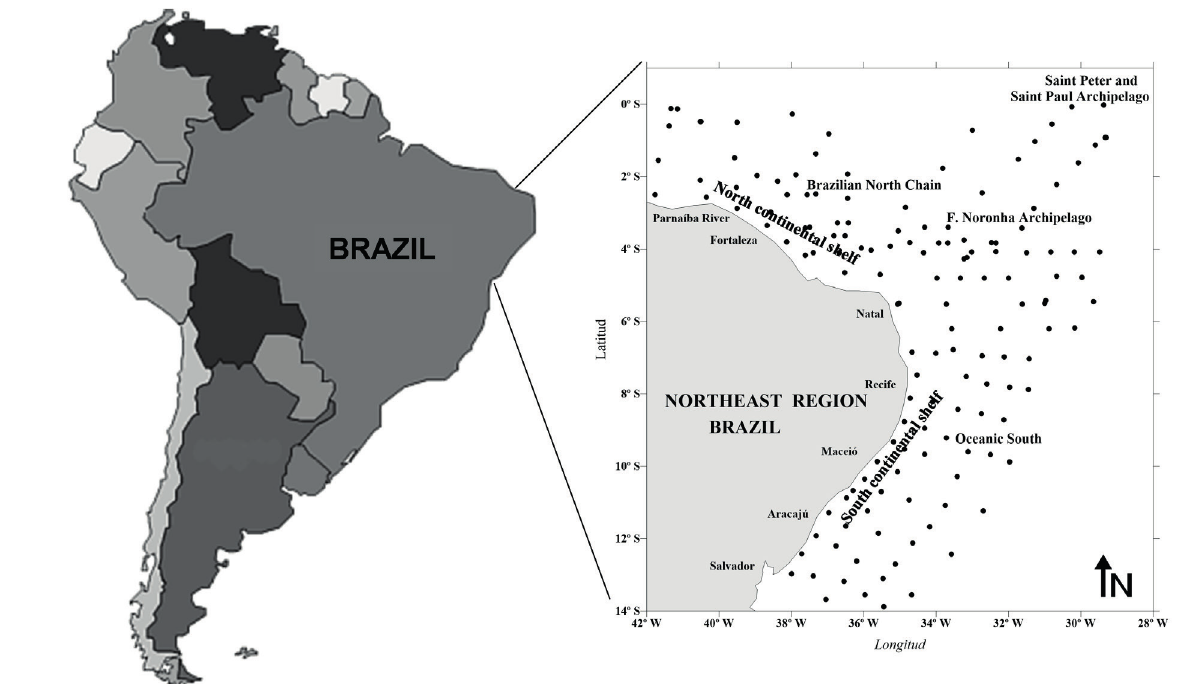
Figure 1 - Study area, showing the sampling stations in the west tropical Atlantic